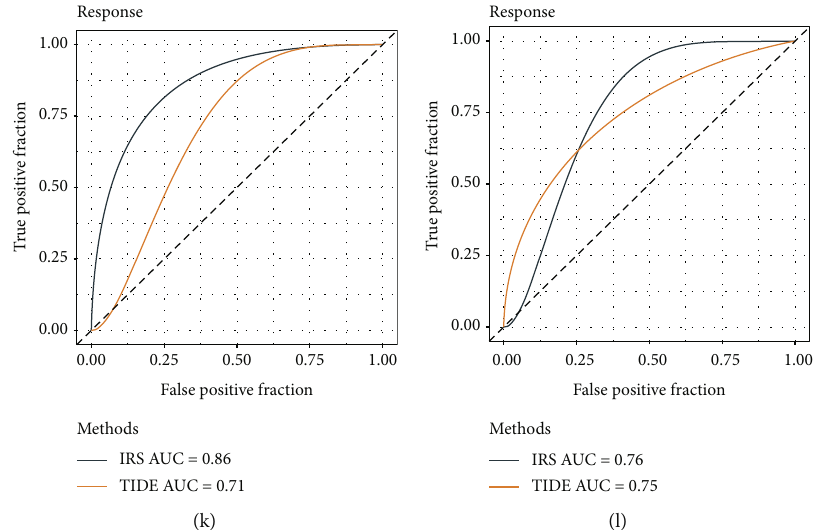
Figure 11: Comparative analysis of IRS and TIDE. (a) IRS survival and ROC curves for the IMvigor210 dataset. (b) TIDE survival and ROC curves for the IMvigor210 dataset. (c) IRS survival and ROC curves for the GSE91061 dataset. (d) TIDE survival and ROC curves for the GSE91061 dataset. (e) IRS survival and ROC curves for the GSE78220 dataset. (f) TIDE survival and ROC curve in the GSE78220 dataset. (g) IRS survival and ROC curves for the GSE135222 dataset. (h) TIDE survival and ROC curves for the GSE135222 dataset. Comparison of IRS and TIDE ROC curves in (i) IMvigor210, (j) GSE91061, (k) GSE78220, and (l) GSE135222